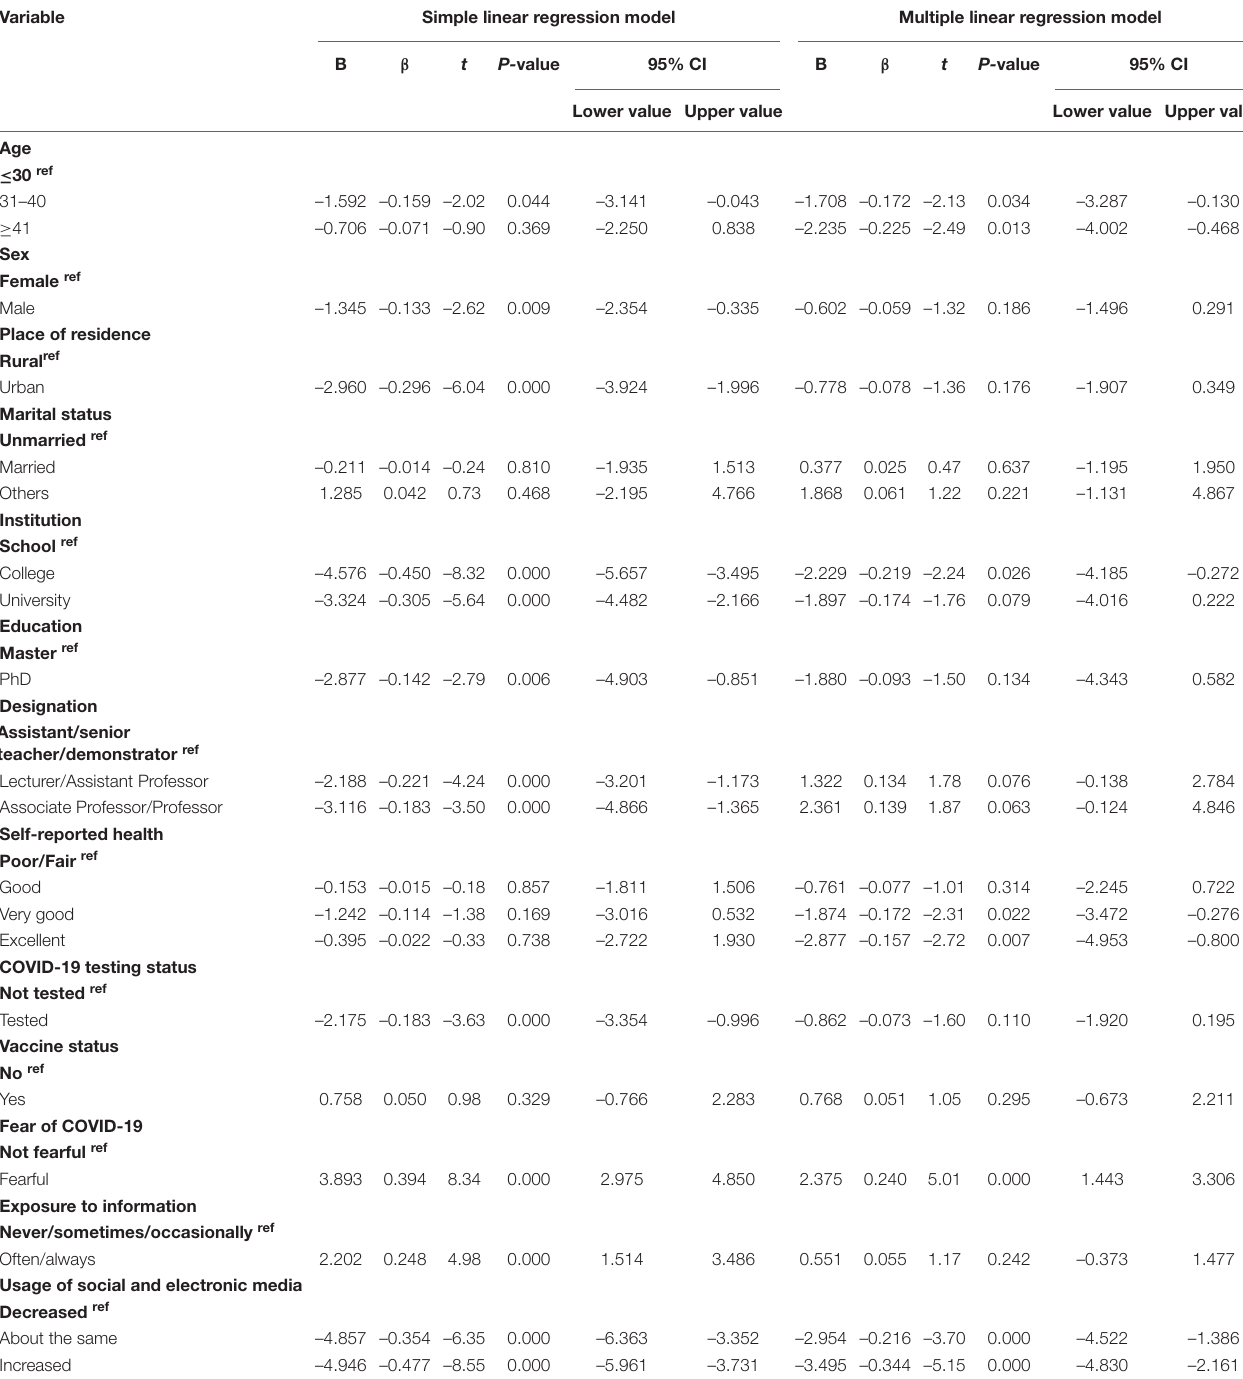
TABLE 4 | Predicting stress among teachers during the COVID-19